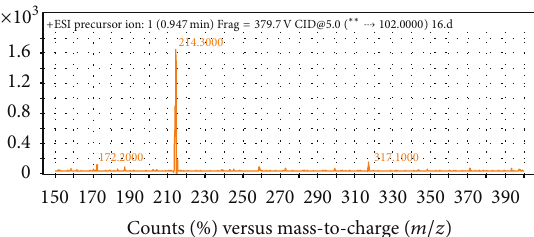
Figure 3: Mass spectrometry analysis of AHL extracts from Pantoea sp. strain M009. Mass spectra of 3-oxo-C6 HSL ( m/z 214.3000) was